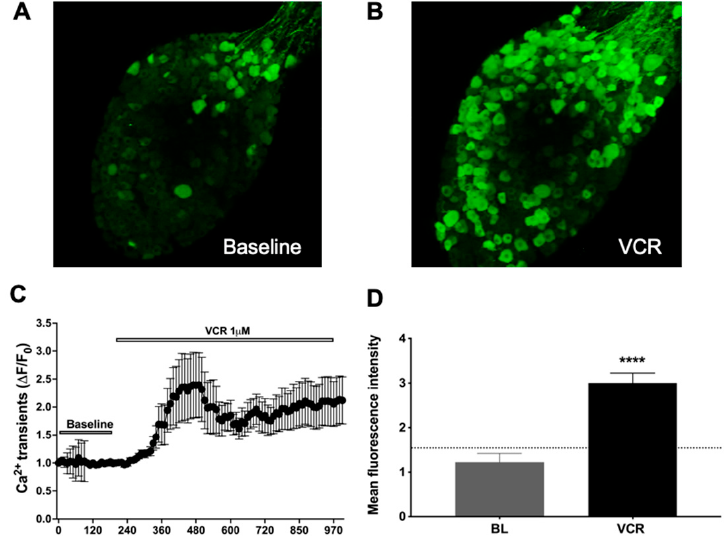
Figure 1. Vincristine-induced effect on vagal afferent neurons at their gastroesophageal nerve ter- minals. ( A ) Z stacked image of nodose ganglia at baseline; ( B ) Z stacked image of nodose ganglia during application of vincristine (VCR, 1 µ M), showing responsive neurons (bright green). Responsive neurons were bright green due to VCR-evoked calcium transients. VCR was only applied to the gastroesophageal vagal afferent nerve terminals; ( C ) Representative traces of calcium transients ( Δ F/F0) in nodose neurons that evoked by VCR; ( D ) Bar graph showing mean fluorescence intensity values for baseline (BL with KBS buffer: 1.06 ± 0.26 ) and VCR (3.8 ± 0.28) (BL vs VCR, **** p < 0.0001, n = 257 neurons from 3 mice).